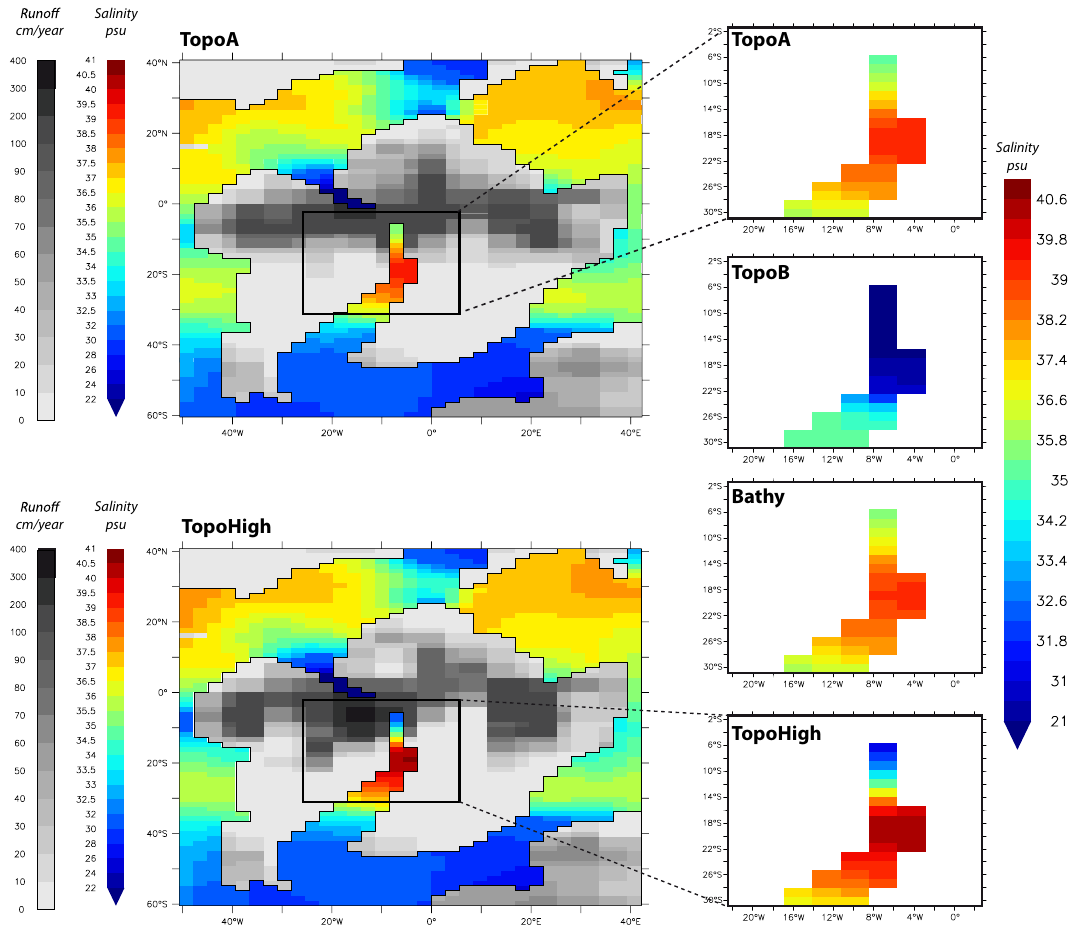
Fig. 3. Annual surface salinity (psu) and annual runoff (cmyr − 1 ) for the TopoA, TopoB, Bathy and TopoHigh runs. The white to black color scale represents the runoff and the blue to red scale the